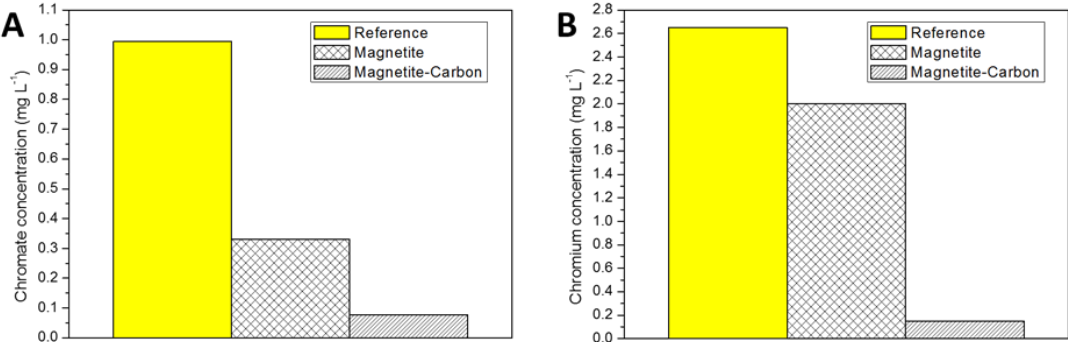
Figure 3. Comparison of the efficiency of magnetite and the magnetite-activated carbon nanocomposite for the removal of hexavalent chromium, with results obtained from ( A ) UV-visible spectrophotometry (UV-vis) and ( B ) atomic absorption spectroscopy (AAS).